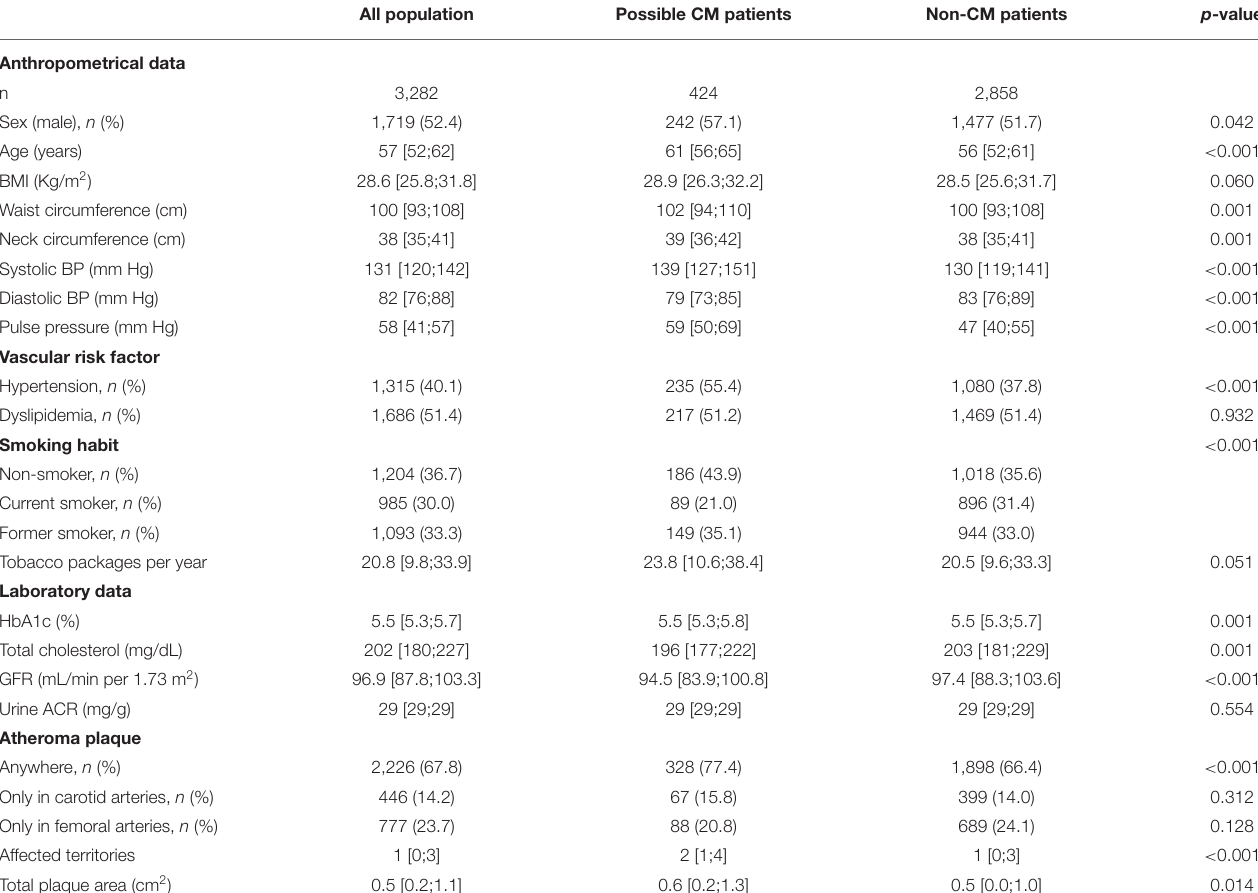
TABLE 1 | Anthropometrical data, cardiovascular risk factor criteria, smoking habit, laboratory results, and prevalence of atheroma plaque from the ILERVAS population according to cerebral microangiopathy. All population Possible CM patients Non-CM patients p